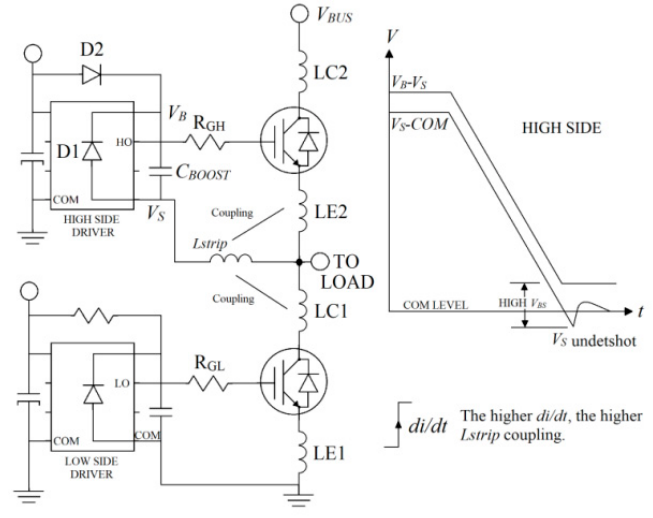
Figure 3. VS-undershoot failure mechanism.